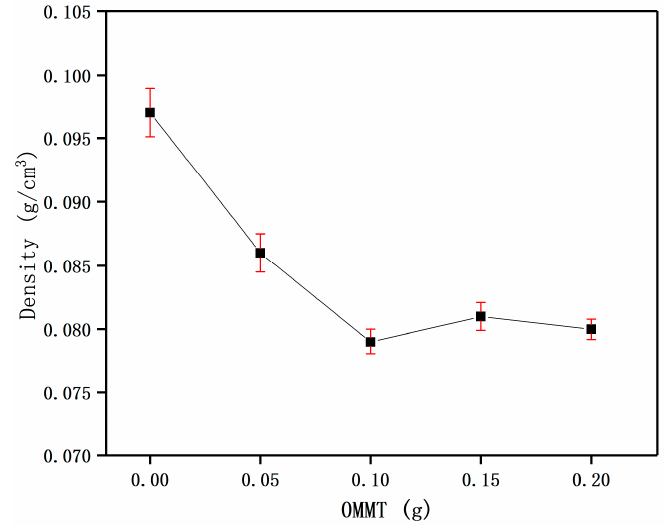
Figure 9. Effect of the dosage of OMMT on foam materials.